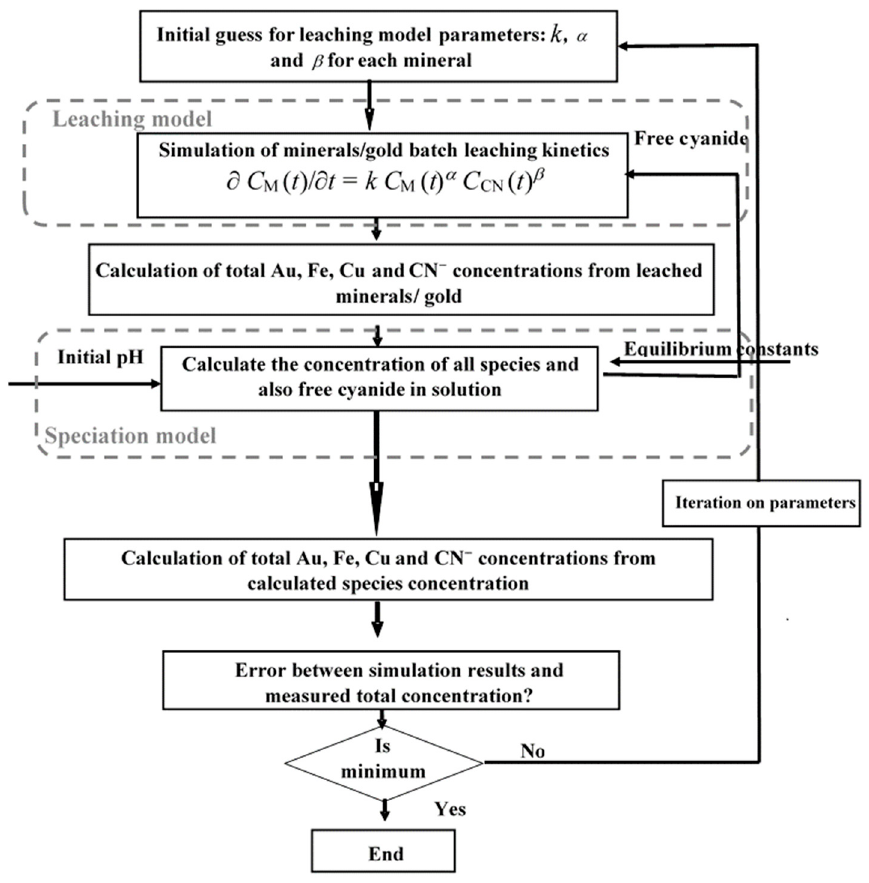
Figure 1. Methodology used for the modeling of mineral leaching, speciation and cyanide consumption.